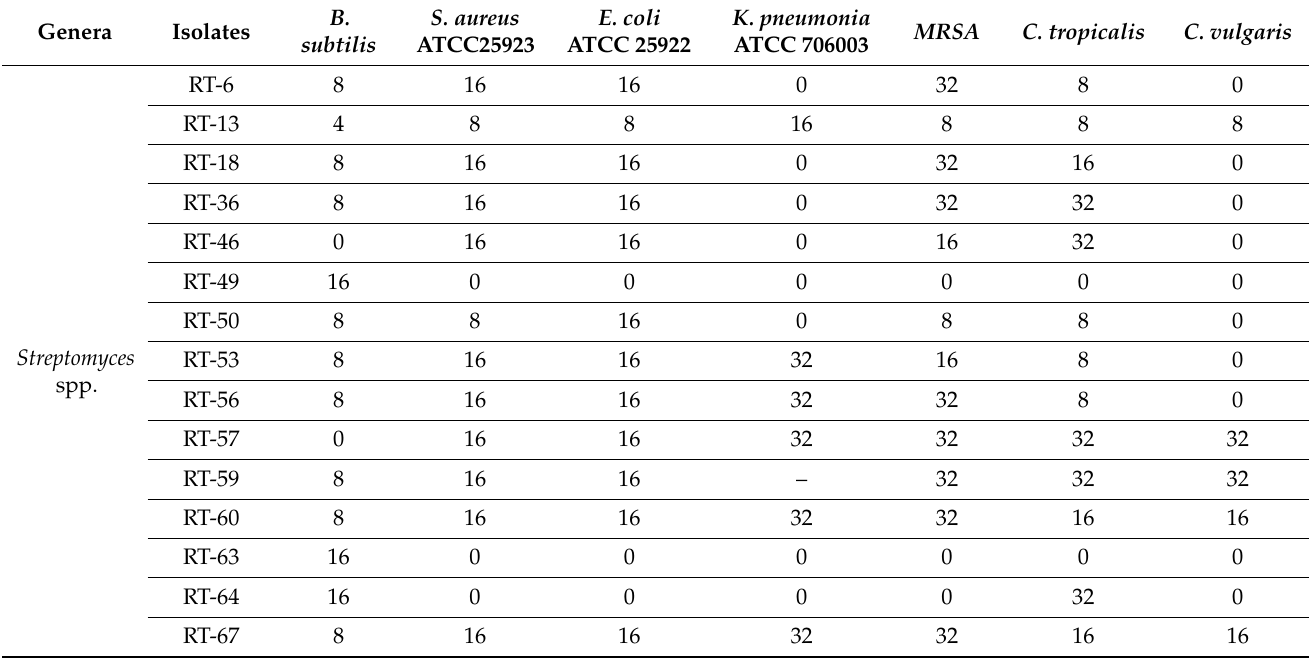
Table 2. MIC (minimal inhibitory concentration) for monitoring the antifungal, antibacterial and antialgal potential of the endophytic actinomycetes isolated from the root and shoot of Parthenium hysterophorus L.